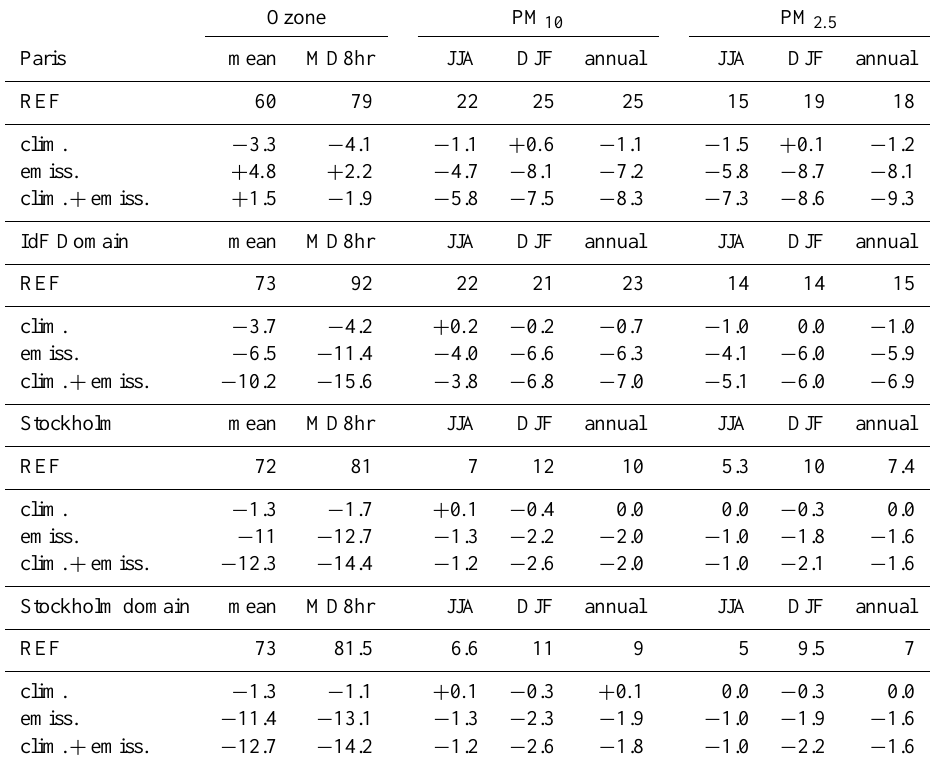
Table 4. Changes in pollutant concentrations (in µgm − 3 ) between present (REF) and 2050 for the IdF and Stockholm regions due to climate change, emission reduction policies and their combined effect. Results are presented separately for the urban centres (Paris and Stockholm cities) and the domain averages. Ozone is averaged over the April–August period.